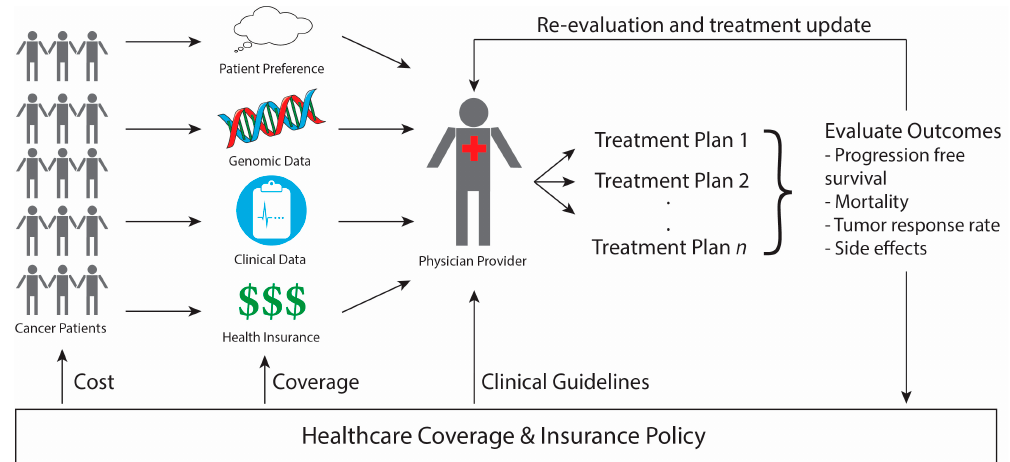
Figure 1. Outline of Precision Medicine in Oncology. Cancer patients have genomic, clinical, and insurance information that is evaluated by the physician, along with patient preferences, to design a potential treatment plan via shared-decision making. The patient’s outcomes are evaluated both to update their individual treatment plan as well as to inform future healthcare policy